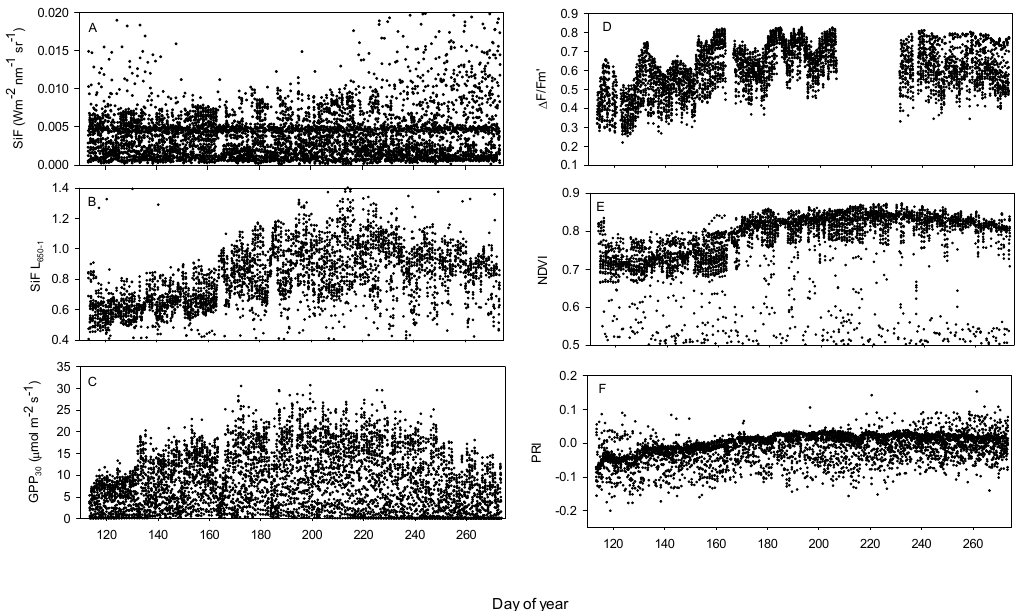
Figure 3. Complete (day and night, all sky conditions) time series of instantaneous observations of ( A ) SiF and ( B ) SiF L 650−1 , both without correction for structural effects and centered on the flux data acquisitions, ( C ) 30 min means of gross primary productivity (GPP) calculated from the flux tower eddy covariance data, ( D ) effective quantum yield ( 𝛥𝐹/𝐹𝑚′ ) measured by the PAM system, ( E ) the normalized difference vegetation index (NDVI), and ( F ) the photochemical reflectance index (PRI), both measured by the Skye sensors mounted on the SMEAR II tall tower. A malfunction of the PAM system resulted in a gap in the 𝛥𝐹/𝐹𝑚′ time series between days of the year 207 and 231.